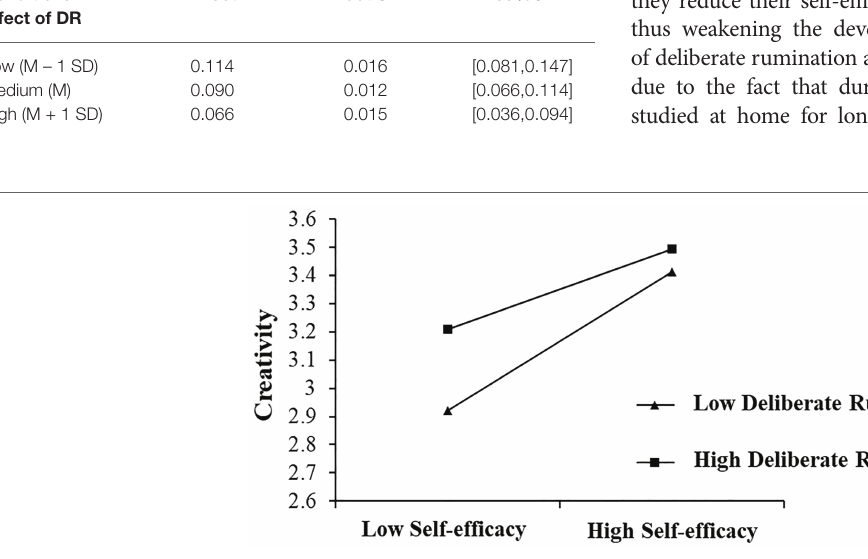
TABLE 5 | Conditional indirect effect at specific levels of deliberate rumination when mediated by general self-efficacy. Conditional Effect Boot SE 95%CI effect of DR